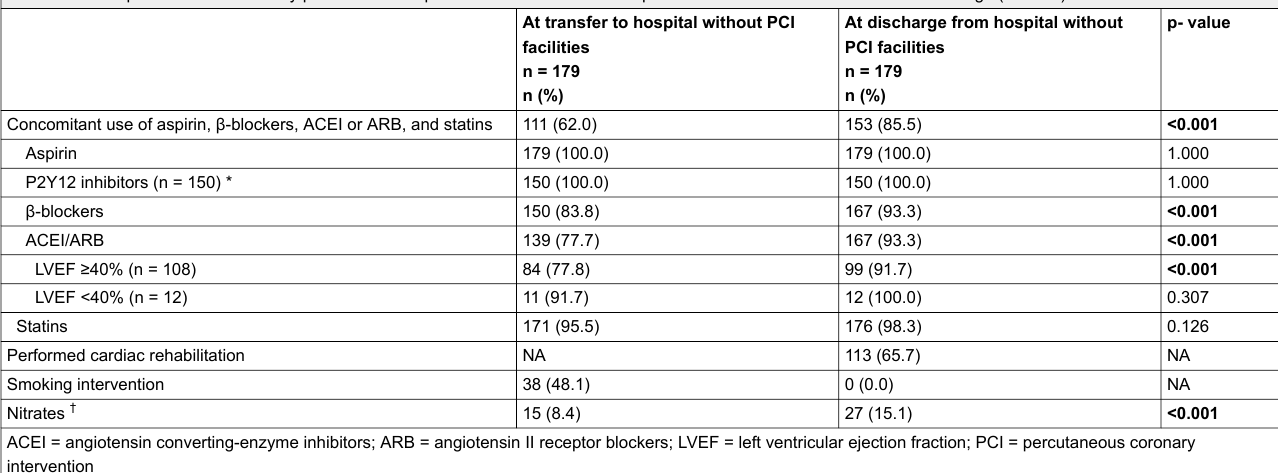
Table 3: Prescription rate of secondary prevention therapies at time of transfer to hospital without PCI facilities and at final discharge (n = 179).